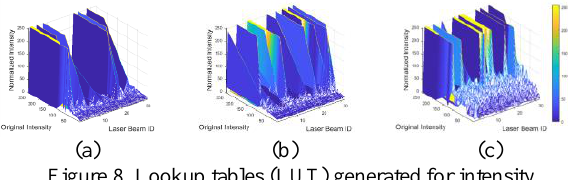
Figure 8. Lookup tables (LUT) generated for intensity normalization of an HDL 32E LiDAR unit in (a) ROI 1, (b) ROI 2, and (c) ROI 3.